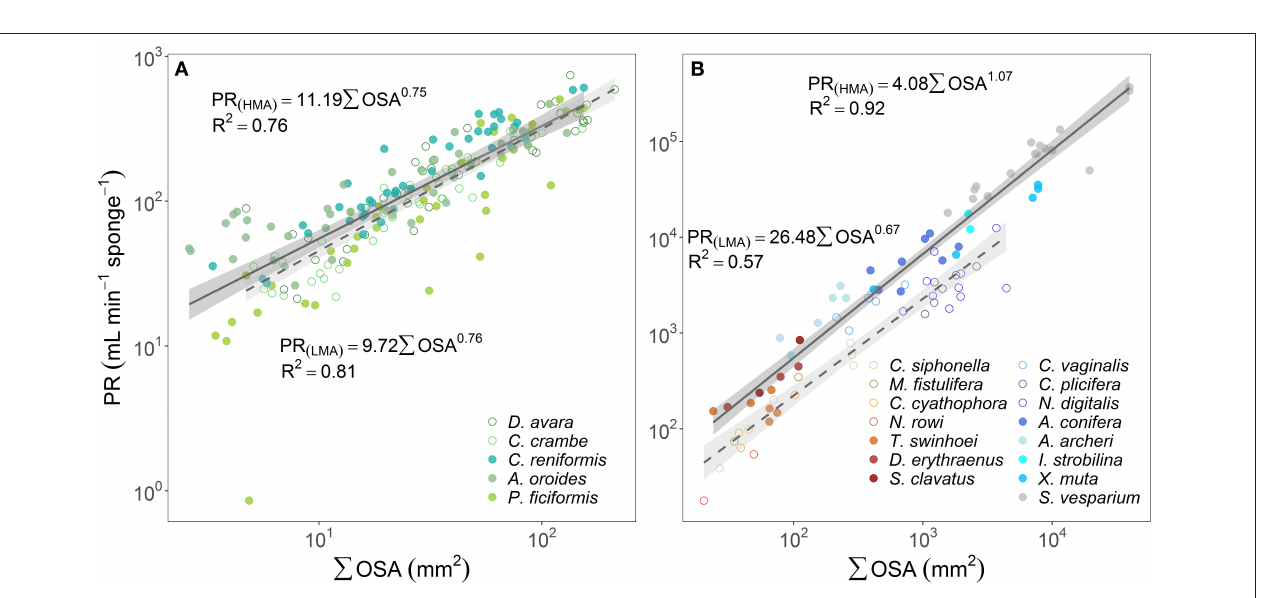
FIGURE 3 | The relationship between the pumping rate (PR, mL min − 1 sponge − 1 ) and the sum of the cross-sectional area of all oscula ( P OSA, mm 2 ) are plotted using log scale in (A) the Mediterranean species and (B) tropical species from Red Sea (reddish color shades) and Caribbean Sea (blue color shades). For the regression analysis, sponges species were clustered accordingly to host type: HMA (closed symbols, solid regression lines) and LMA (empty symbols, dashed regression lines). The scaling exponents and coefficients calculated for HMA and LMA separately are shown in each panel and the shade areas represent the 95% confidence interval for the regression line. The b scaling exponents were statistically different from zero for all equations ( p < 0.001). The scaling exponents and coefficients calculated separately for each Mediterranean species are shown in Supplementary Table 3A . Note different log-log scale between the two